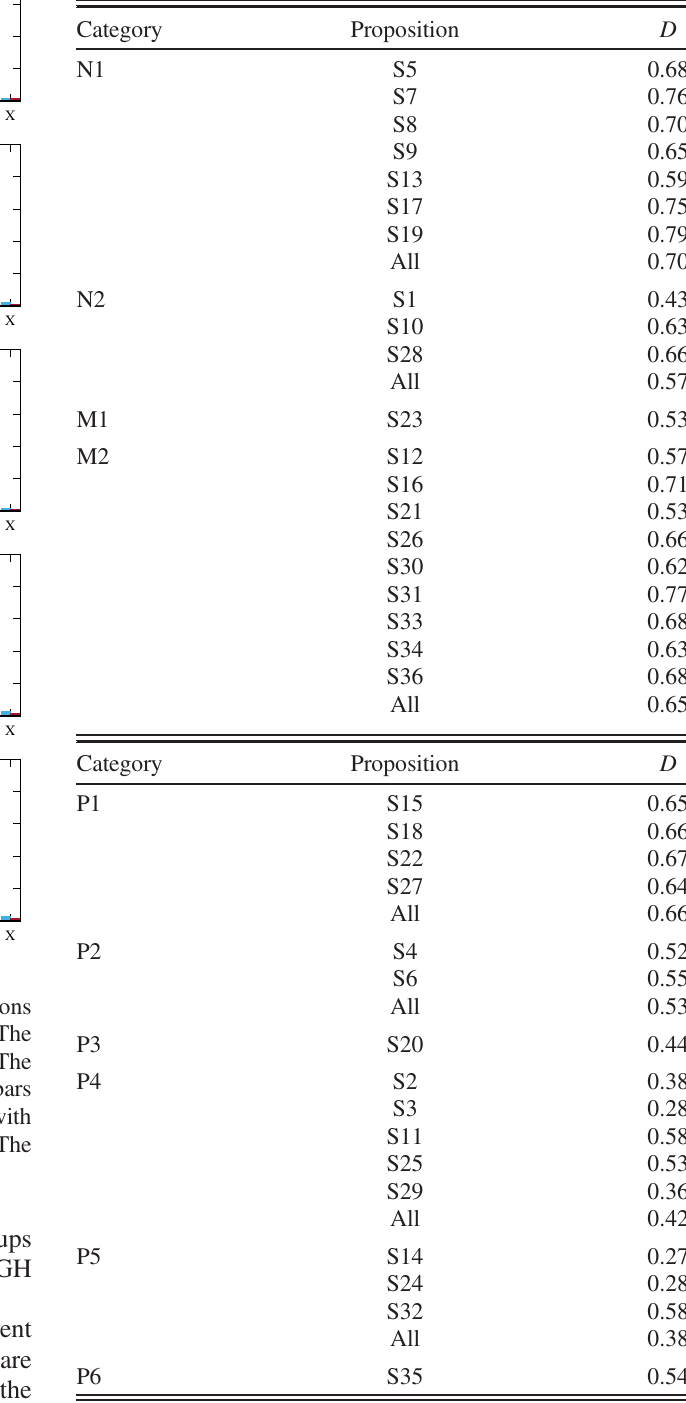
TABLE VI. Discrimination index ( D ) of propositions and epistemic